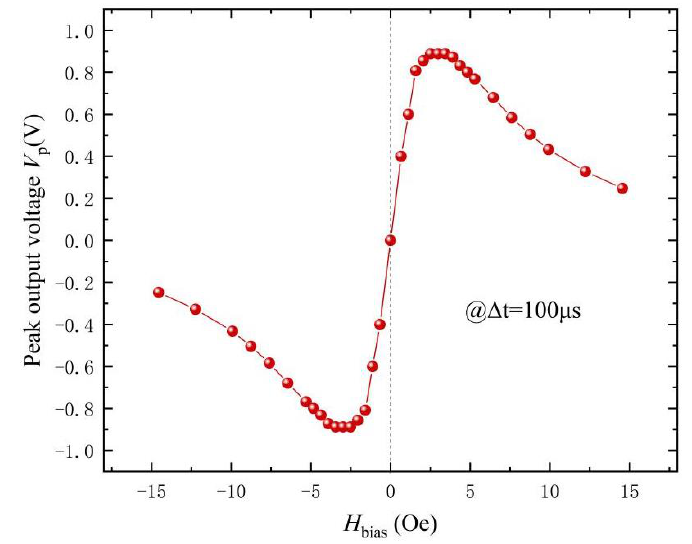
Figure 5. The peak output voltage V p (maximum V o in Figure 3) as a function of H bias for the FeCuNbSiB/piezofiber structure driven by the pulsed magnetic field with Δt = ~100 μs.